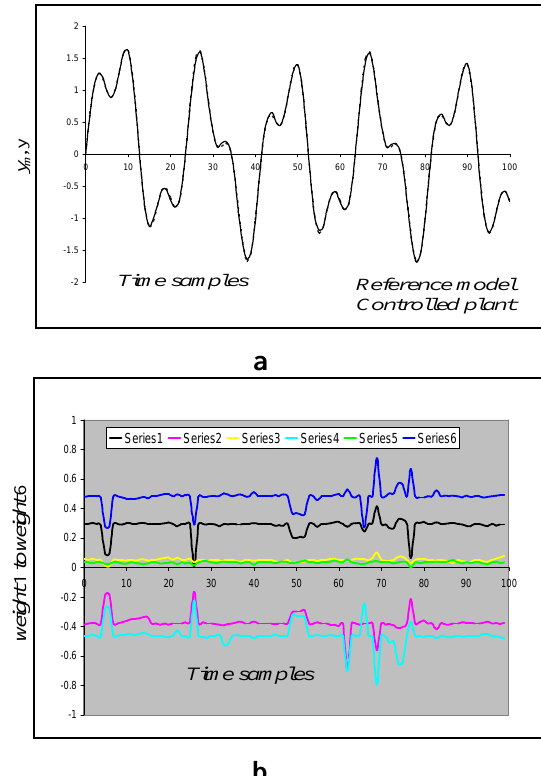
Fig. 5. Plant 3 (a) outputs of the reference model and the controlled plant (b) on-line adaptation of the six weights in the SRWNN